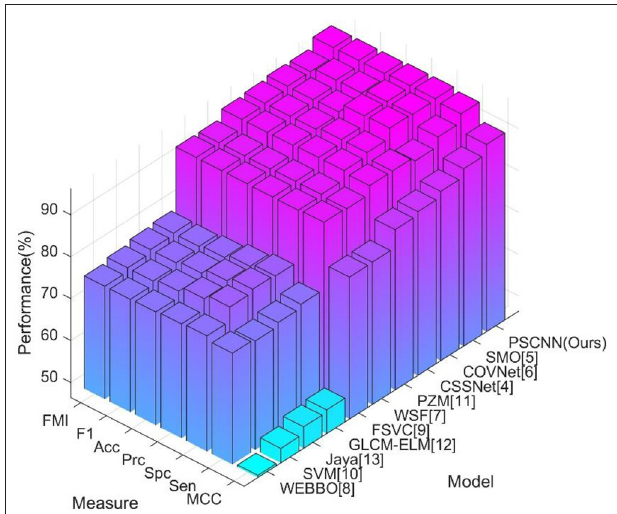
FIGURE 16 | Comparison to state-of-the-art (SOTA) models, which are sorted with regards to Matthews Correlation Coefficient (MCC).